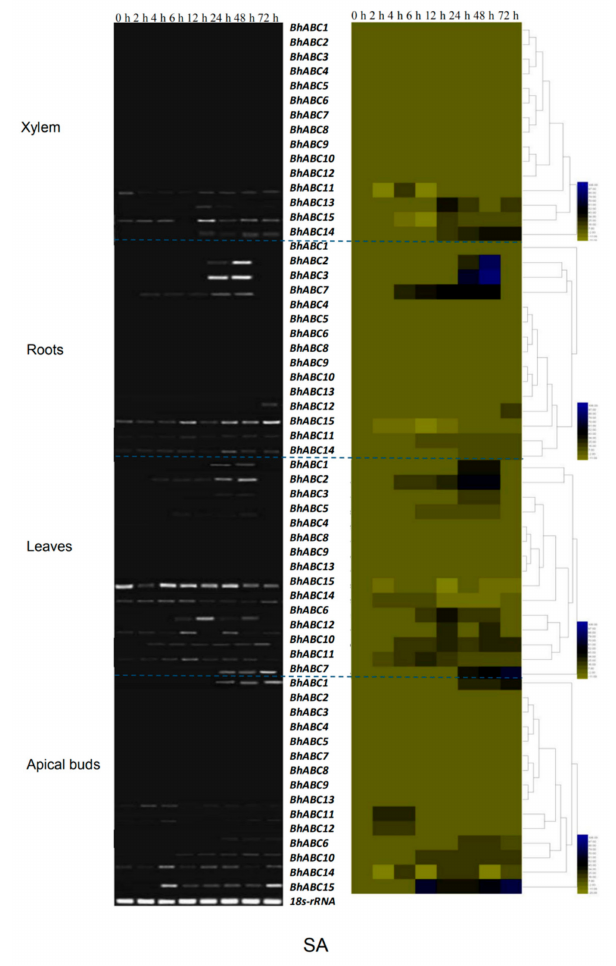
Figure 6. Expression patterns of BhABC genes in xylem, roots, leaves, and apical buds after SA treatment. Heat map showing responses of BhABC genes to SA (right); semi-quantitative RT-PCR analysis with 18s RNA internal reference